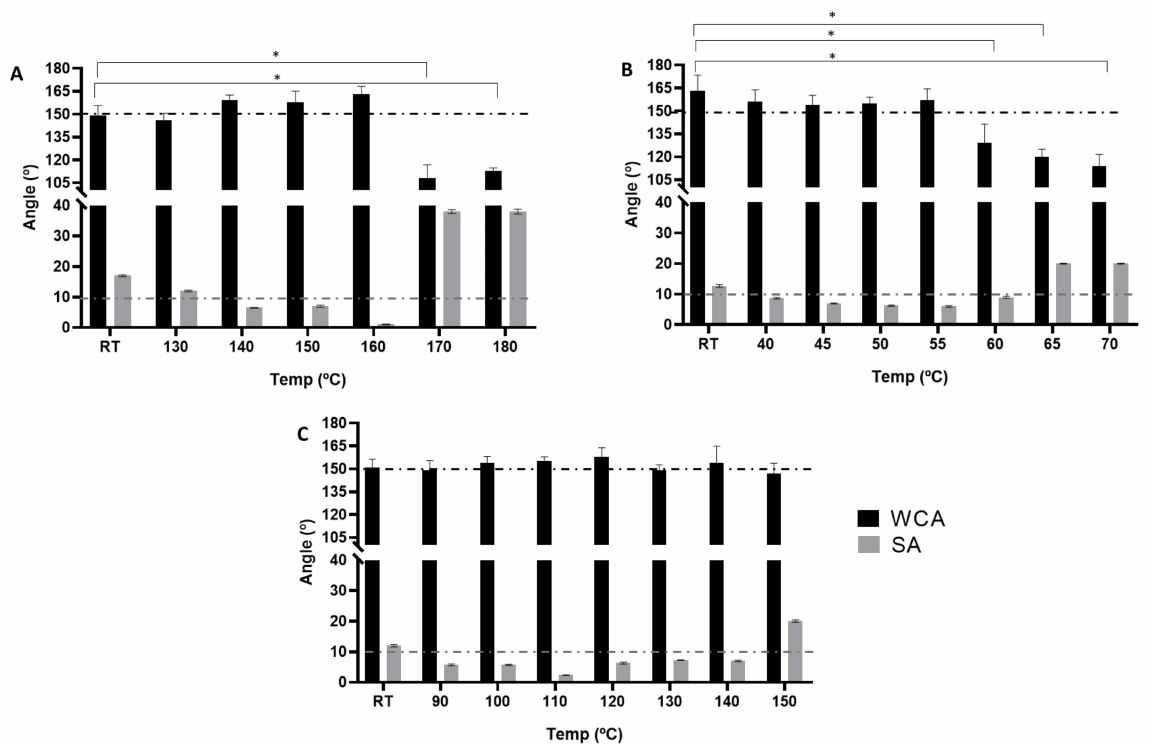
Figure 6. Apparent water contact angle (WCA) and sliding angle (SA) before and after thermal post-treatment at different temperatures of the multilayer structures based on paper, electrospun polylactide (PLA), poly( ε -caprolactone) (PCL), and poly(3-hydroxybutyrate-co-3-hydroxy-valerate) (PHBV) mats, and electrosprayed hydrophobic silica microparticles. ( A ) Paper/PLA/SiO 2 for 20 s; ( B ) Paper/PCL/SiO 2 for 20 s; ( C ) Paper/PHBV/SiO 2 for 20 s. Black line at 150 ◦ C represents the minimum WCA and grey line at 10 ◦ C the max SA to be defined as superhydrophobic. RT means at room temperature. Asterisks indicate statistical differences between the room temperature and annealed samples (* p <